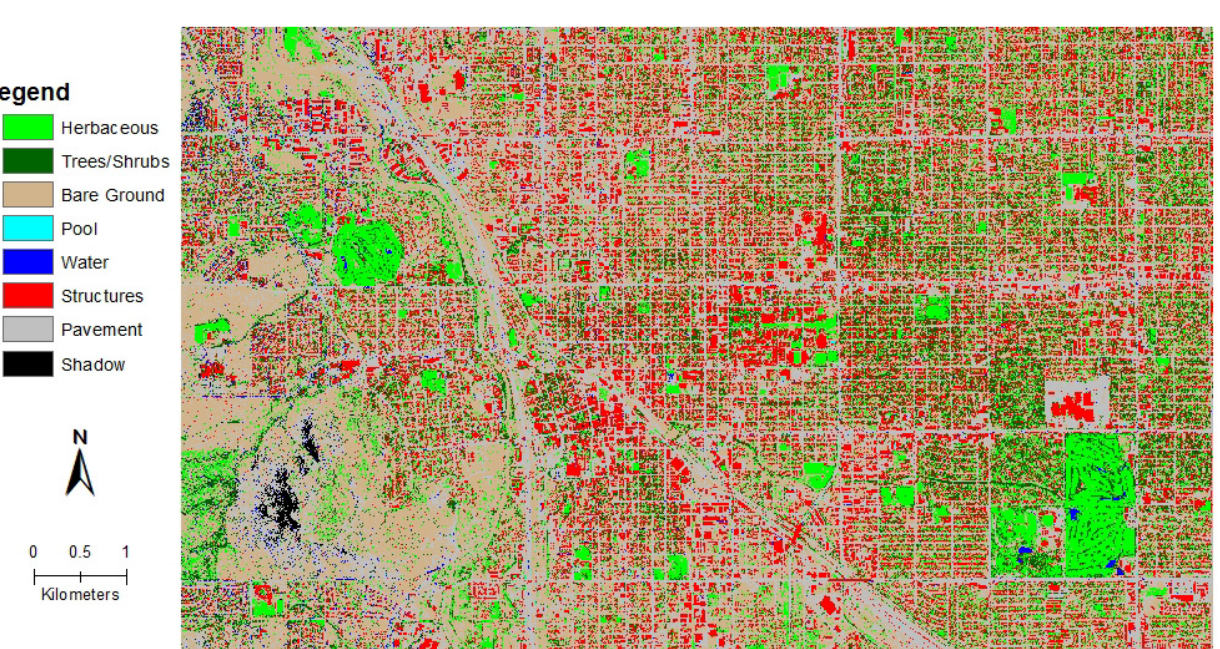
Figure 5. Land Cover/Land Use map based on CART classification performed using 2007 4-band NAIP data, NDVI data, and 2008 LiDAR CHM